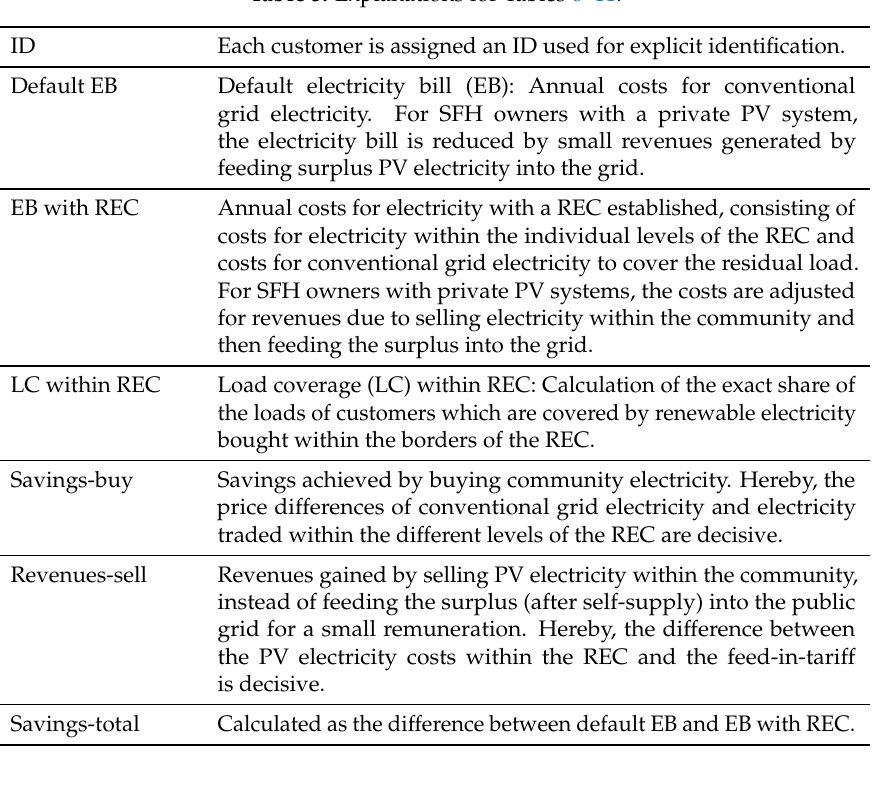
Table 5. Explanations for Tables